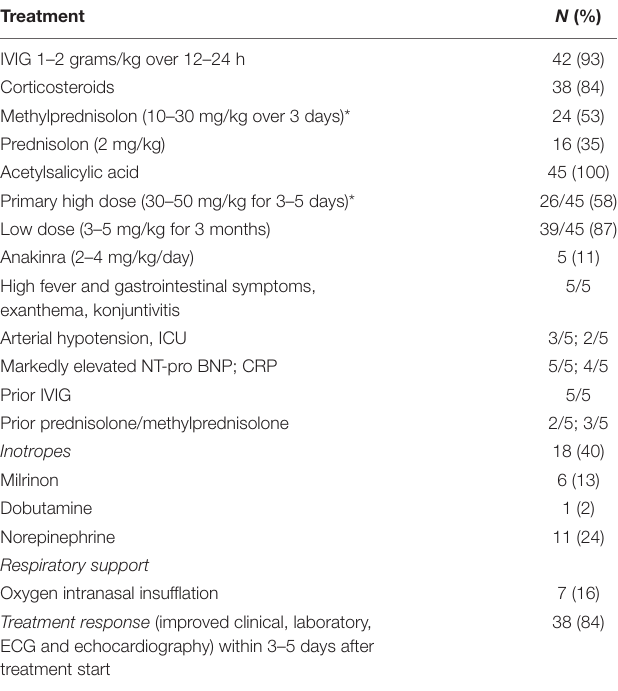
TABLE 5 | PIMS treatment and outcome.